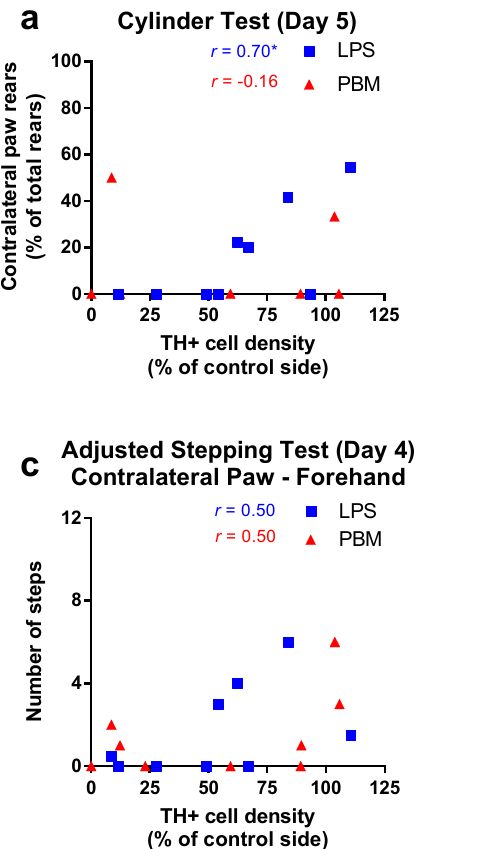
Figure 6. The relationship between TH + cell density and motor behaviour in the cylinder, rotarod, and adjusted stepping tests following 20 µ g LPS injection and PBM treatment. ( a ) A significant positive relationship between TH + cell density and cylinder test performance was found for the LPS group at post-surgery day 5 (* p < 0.05) but not for the PBM group. Vehicle: n = 7; LPS: n = 9; PBM: n = 8. ( b ) A significant positive relationship existed between TH + cell density and rotarod performance for LPS rats at post-surgery day 4 (* p < 0.05), but not the PBM group. Vehicle: n = 7; LPS: n = 9; PBM: n = 9. ( c ) No significant relationship existed between the contralateral (right) paw forehand stepping performance and TH + cell density for LPS or PBM rats at post-surgery day 4. Vehicle: n = 7; LPS: n = 9; PBM: n = 9. ( d ) A significant positive relationship existed between TH + cell density and contralateral paw backhand stepping performance for LPS rats at post-surgery day 4 (* p < 0.05), but not PBM-treated rats. Vehicle: n = 7; LPS: n = 9; PBM: n = 9. r values represent Pearson’s correlation coe ffi